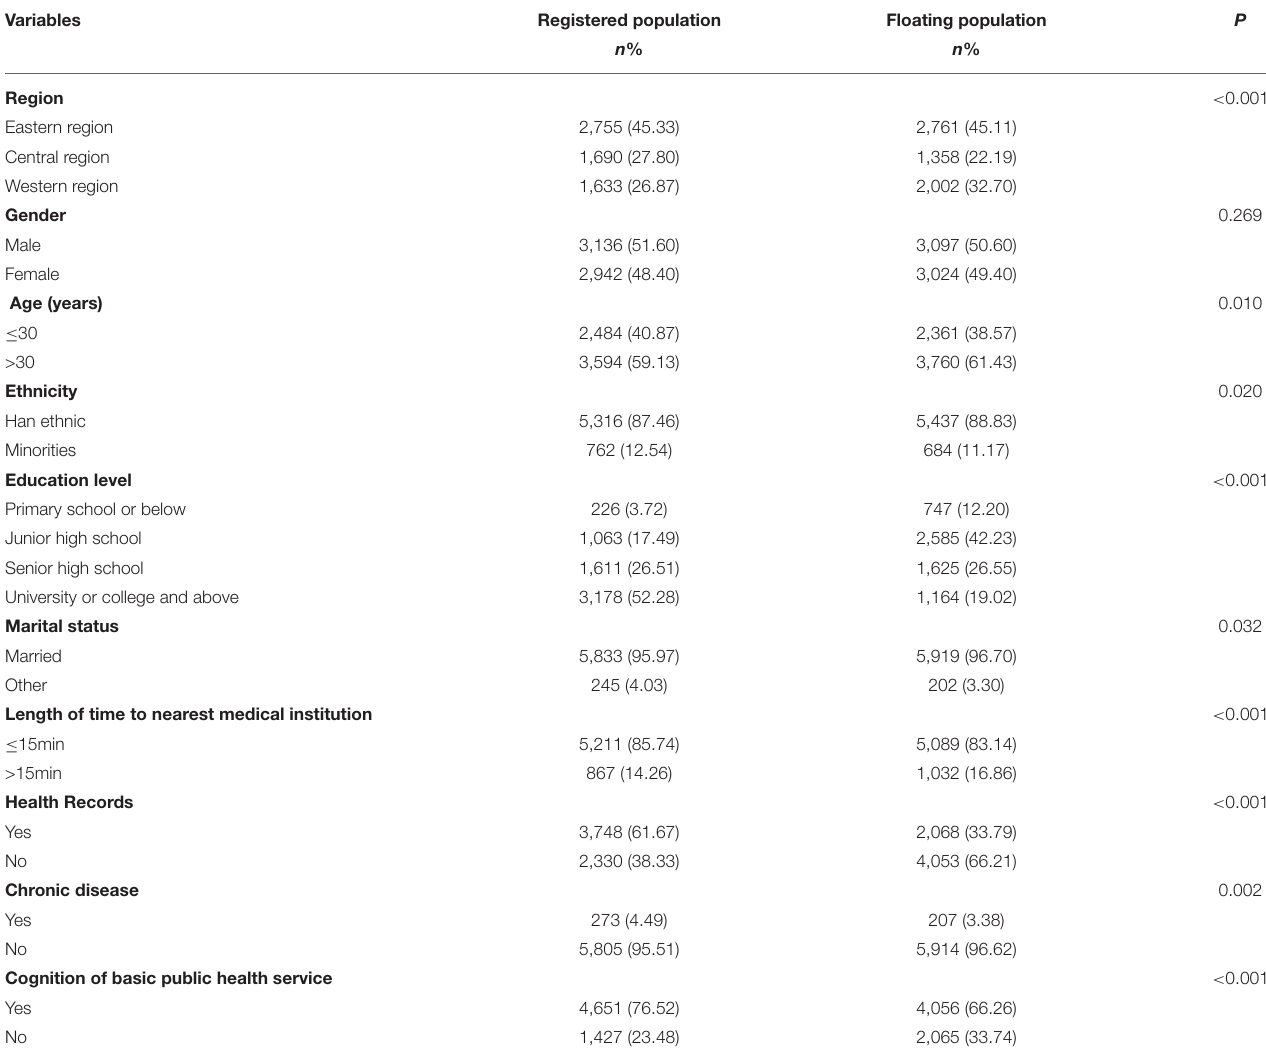
TABLE 1 | Characteristics of participants ( N = 12,199).